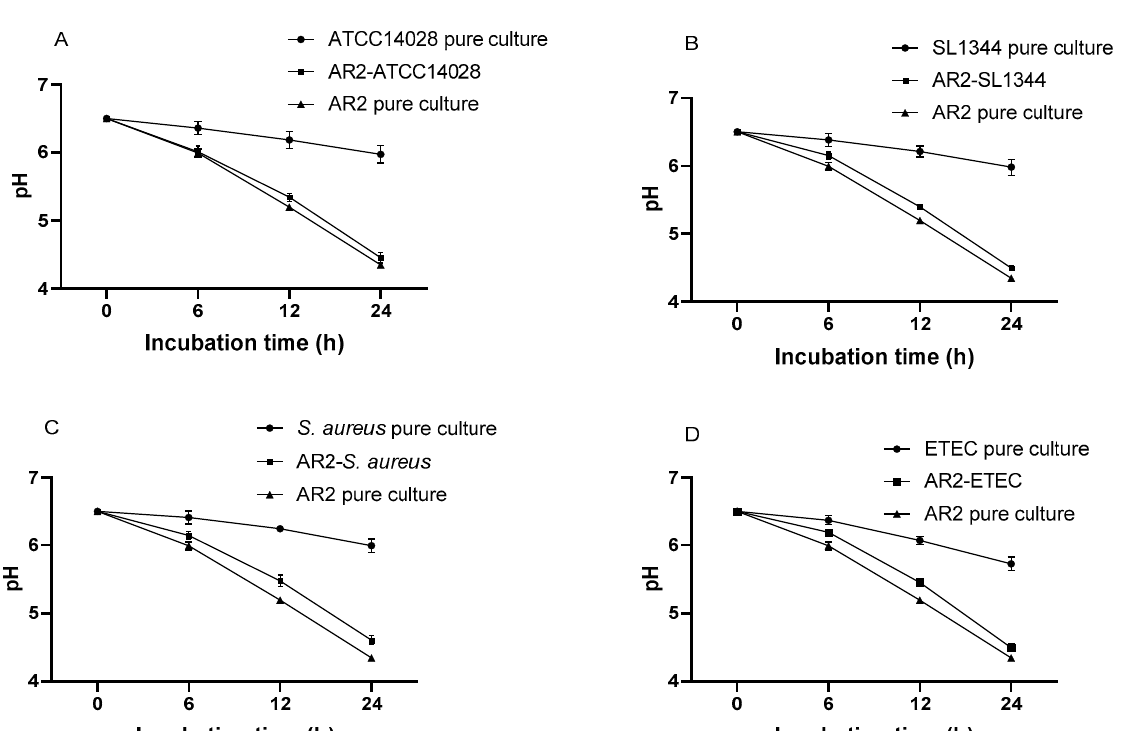
Figure 8. pH decline patterns of pure cultures of L. acidophilus AR1 and different pathogens, and co- cultures of L. acidophilus AR1 with S. Typhimurium ATCC14028 ( A ), S. Typhimurium SL1344 ( B ), S. aureus ( C ), and ETEC ( D ).